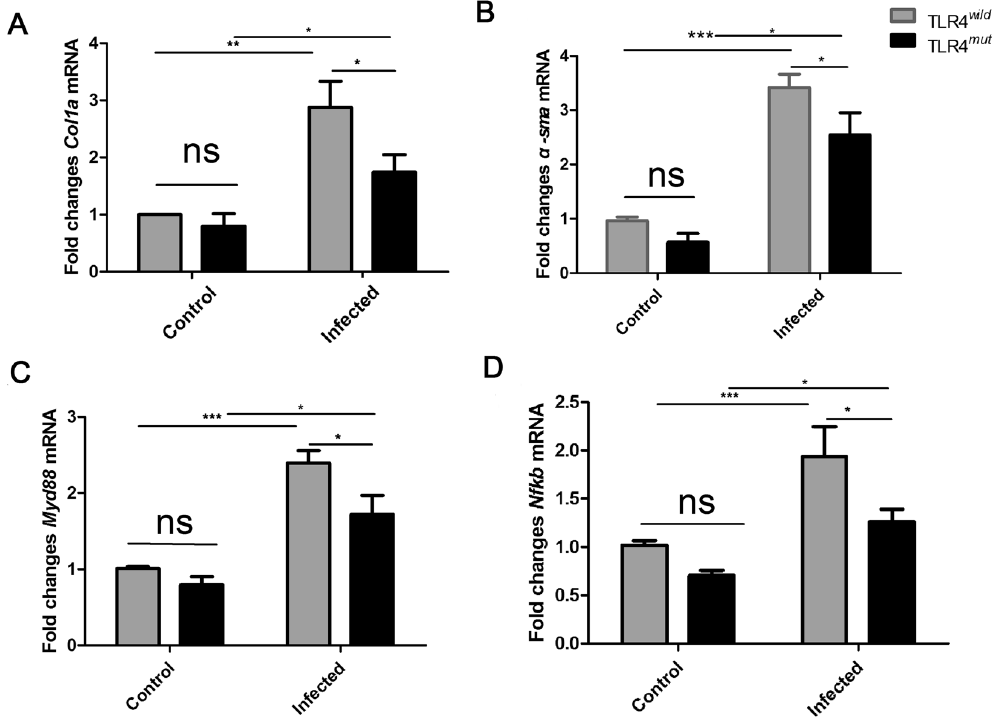
Figure 3. The relative expression of Nfkb , Myd88 , Col1a and α - sma transcripts in the liver of TLR4 wild and mutated mice infected by with or without Clonorchis sinensis . The sections of tissue containing bile ducts were homogenated. Total RNAs were extracted and reverse transcribed to complementary DNA. Fold changes of Col1a ( A ), α -sma ( B ), Myd88 ( C ) and Nfkb ( D ) transcripts to β -actin were measured by real-time qPCR. The data were obtained from 3~5 mice of three-independent experiment. The values were expressed as mean ± SEM. Compared with indicated mice * P < 0.05, ** P < 0.01, *** P <